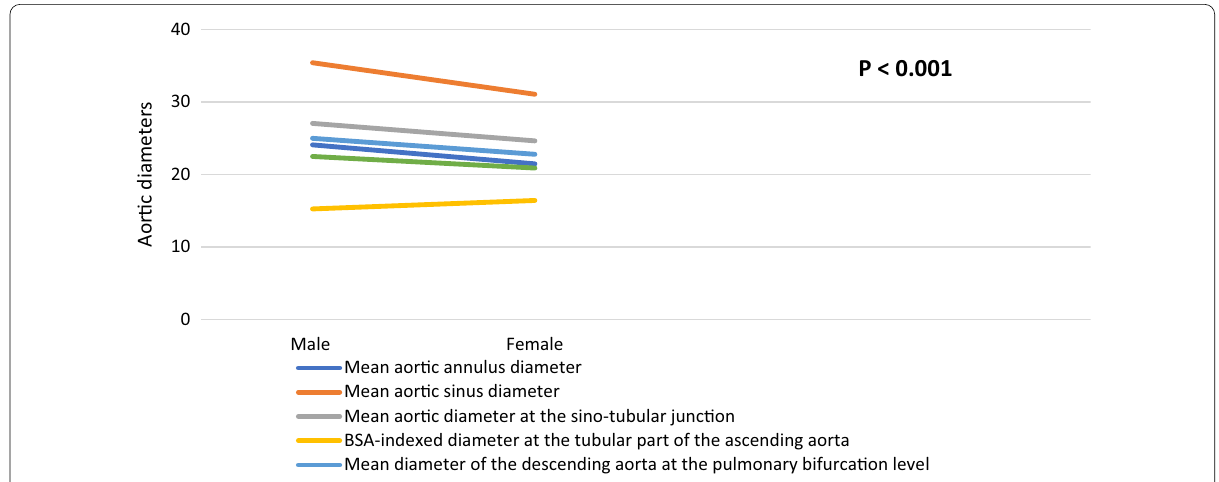
Bold mean significant values that is less than or equal 0.05